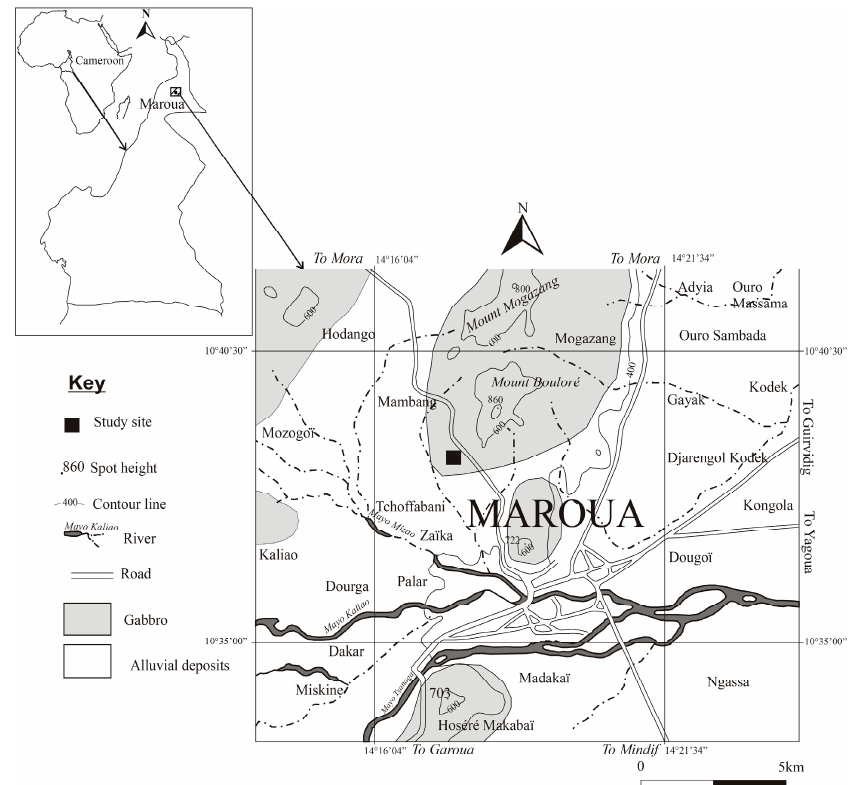
Figure 1. Location and geological map of the study site.